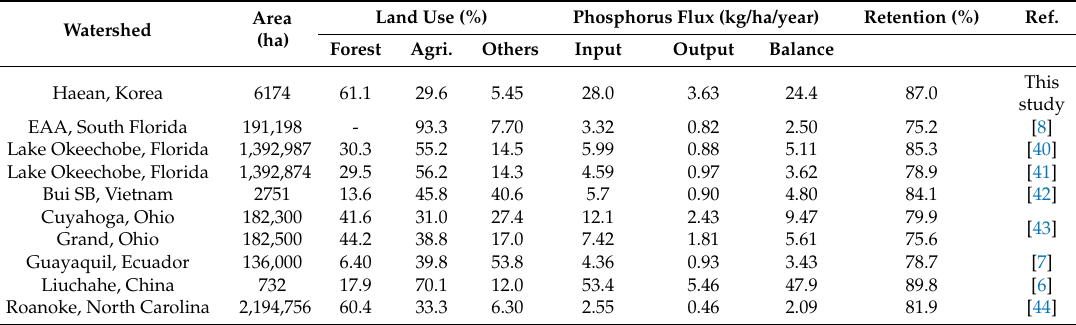
Table 9. Comparison of the P budget in this study with P budgets for other watersheds.